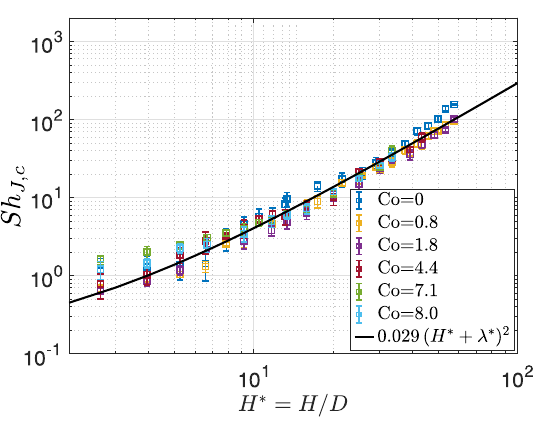
Figure 4. Local cohesive Shields number Sh (cid:96), c for varying inter- particle cohesion. The color code is the same as in Fig. 3 and the horizontal dashed line is given by Sh (cid:96), c =